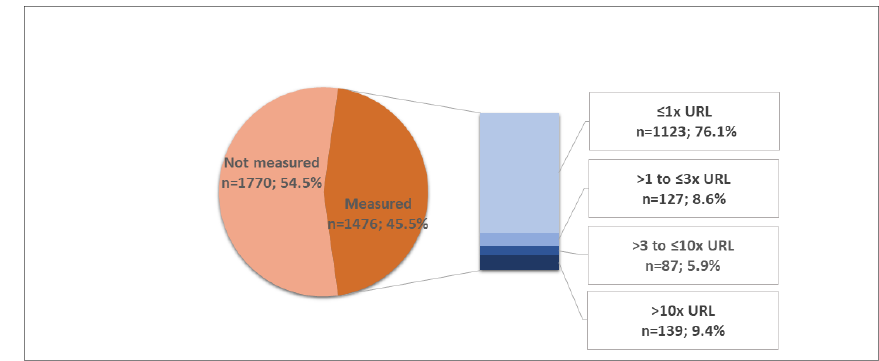
Figure 1. Prevalence of myocardial injury during the first week of hospitalization. Troponin ratios were categorized as normal ( ≤ 1 × URL) and mildly (>1 to ≤ 3 × URL), moderately (>3 to ≤ 10 × URL), and severely (>10 × URL) elevated. URL, upper reference limit.